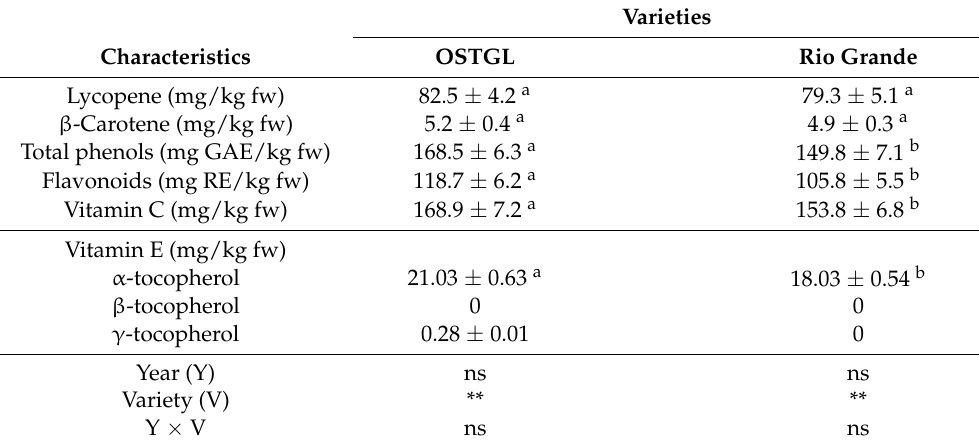
Table 3. Lycopene, carotenoids, total phenols, flavonoids, vitamin C, and vitamin E contents in the different tomato varieties grown organically.